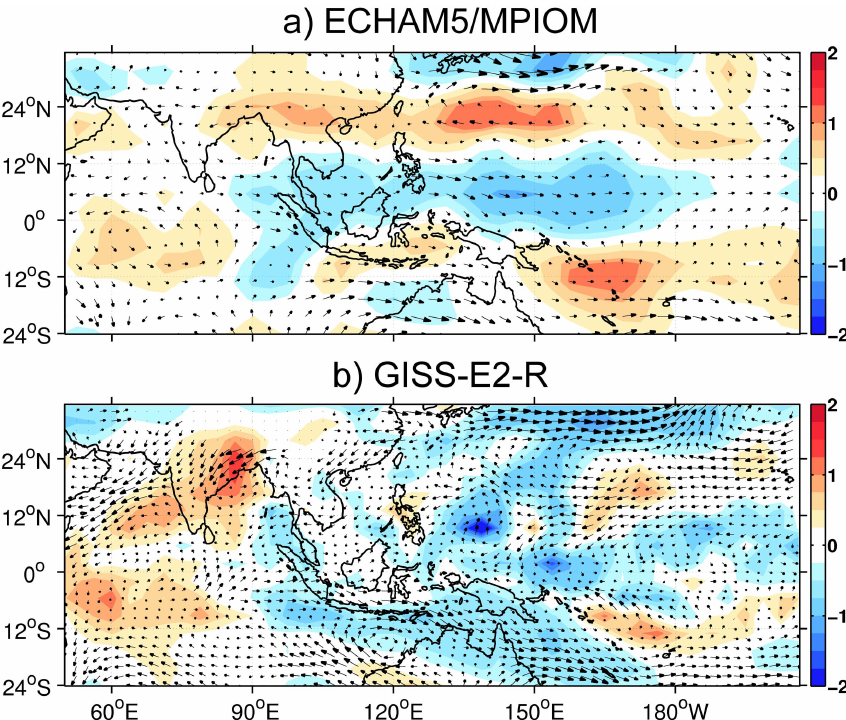
Figure 9. Model simulations’ composite anomalies of 850hPa wind (ms − 1 ) and OLR (Wm − 2 ) for the five mega-droughts (84 years in total) of the past millennium from (a) ECHAM5/MPIOM and (b) GISS-E2-R. The largest wind vector in (a) is 0.33ms − 1 ; in (b) it is 1.02ms − 1